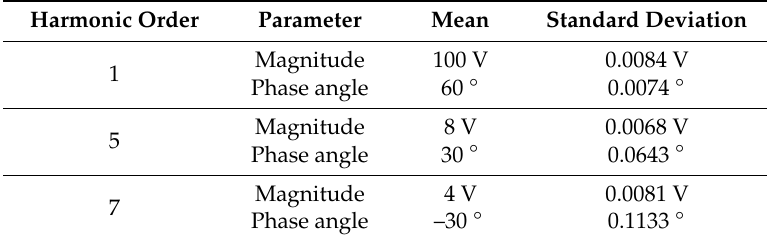
Table 1. Mean and standard deviations of voltage harmonics magnitudes and phase